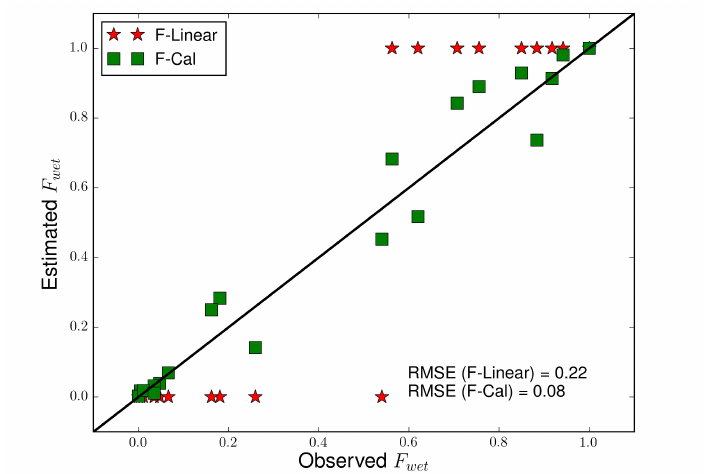
Figure 16. Comparison of the observed and estimated F wet for the F-Linear and F-Cal experiments at a spatial resolution of 500